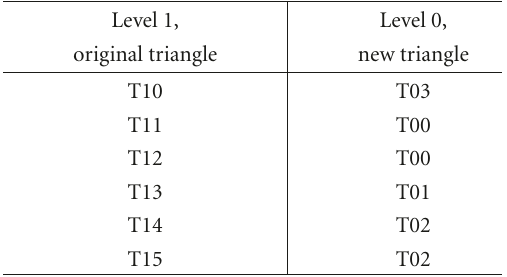
Figure 3: Result of reflection followed by expansion of triangle T00 as outlined in Table 1. The original triangle T00 is shown using a solid line and the resulting level 1 triangles are shown using dotted lines. Table 2: Contraction from level 1 to level 0